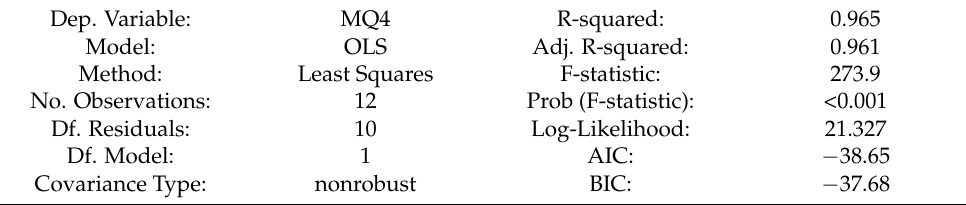
Table 3. OLS regression results